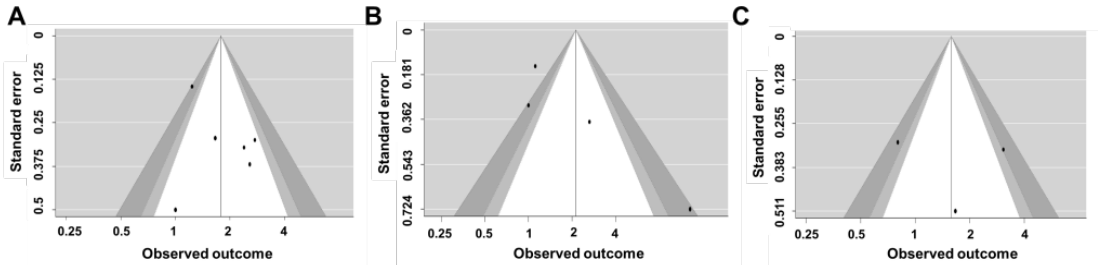
Figure 6. Funnel plot of the results of the studies included ( A ) funnel plot of cognitive function, ( B ) funnel plot of BADL, and ( C ) funnel plot of IADL.